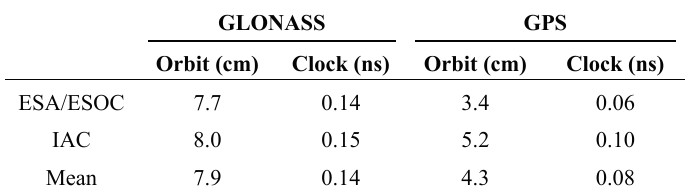
Table 1. RMS statistics of CNES satellite orbit 3D errors and clock errors on 1 February